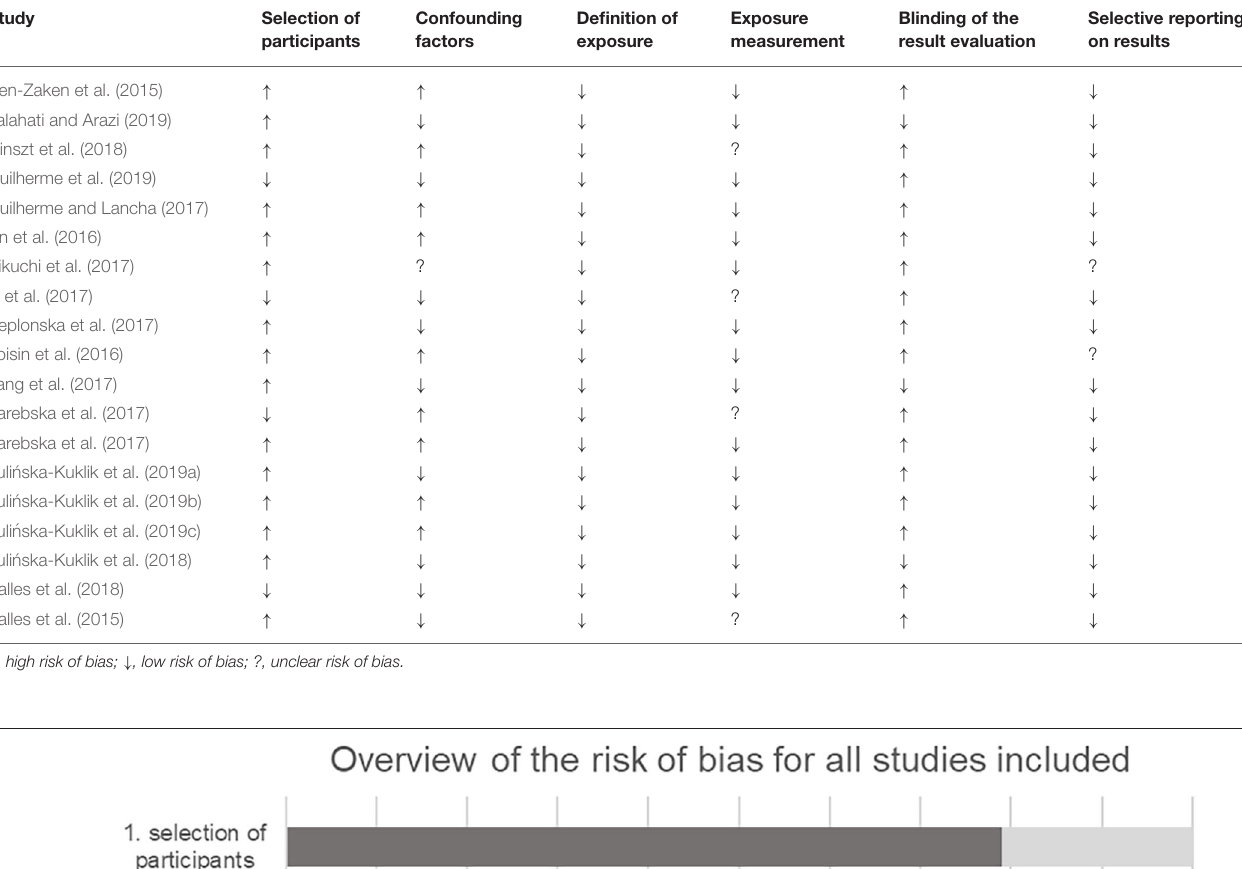
TABLE 5 | Summary of the quality assessment of all included studies on endurance performance and muscle strength as well as on injury susceptibility. Study Selection of